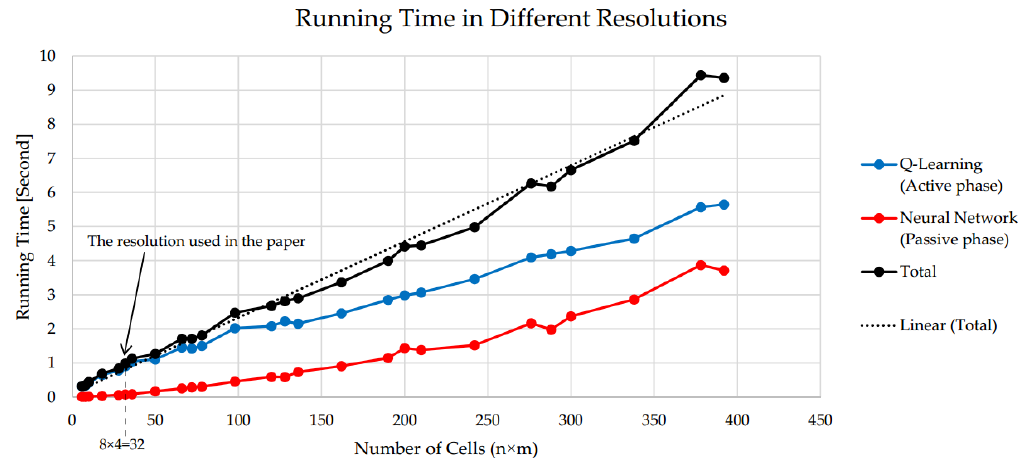
Figure 9. Running time vs. number of cells: 1. Total running time in black, 2. Q-learning running time (active phase) in blue, 3. Neural network running time (passive phase) in red.